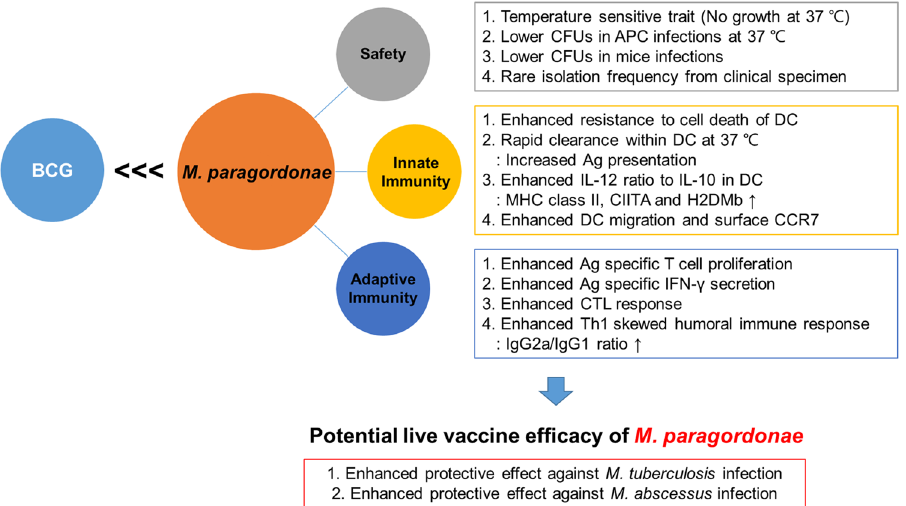
Figure 9. Schematic representation showing enhanced vaccine efficacy of M. paragordonae (Mpg). Compared to BCG, Mpg plays a pivotal role as an attenuated live vaccine in protecting against infections with Mtb and Mab via enhanced innate and adaptive immune responses and is safer for mice intravenous infections as well as in infections of